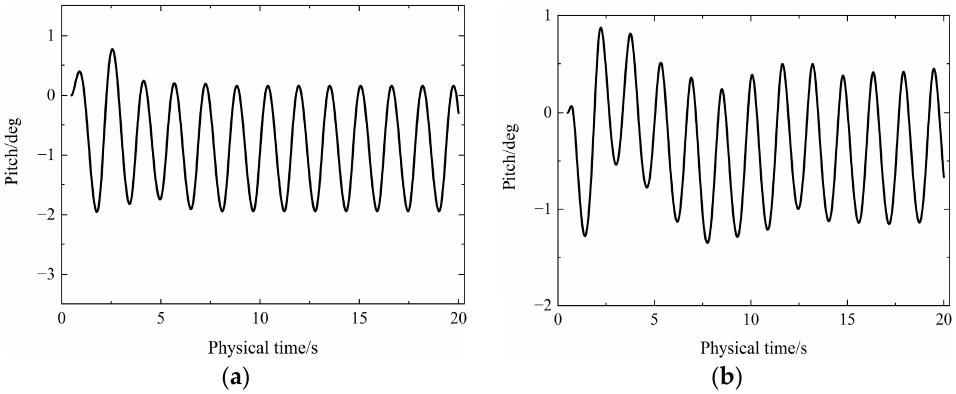
Figure 25. The time history curve of pitch angle under case 7: ( a ) monohull; ( b ) pentamaran.